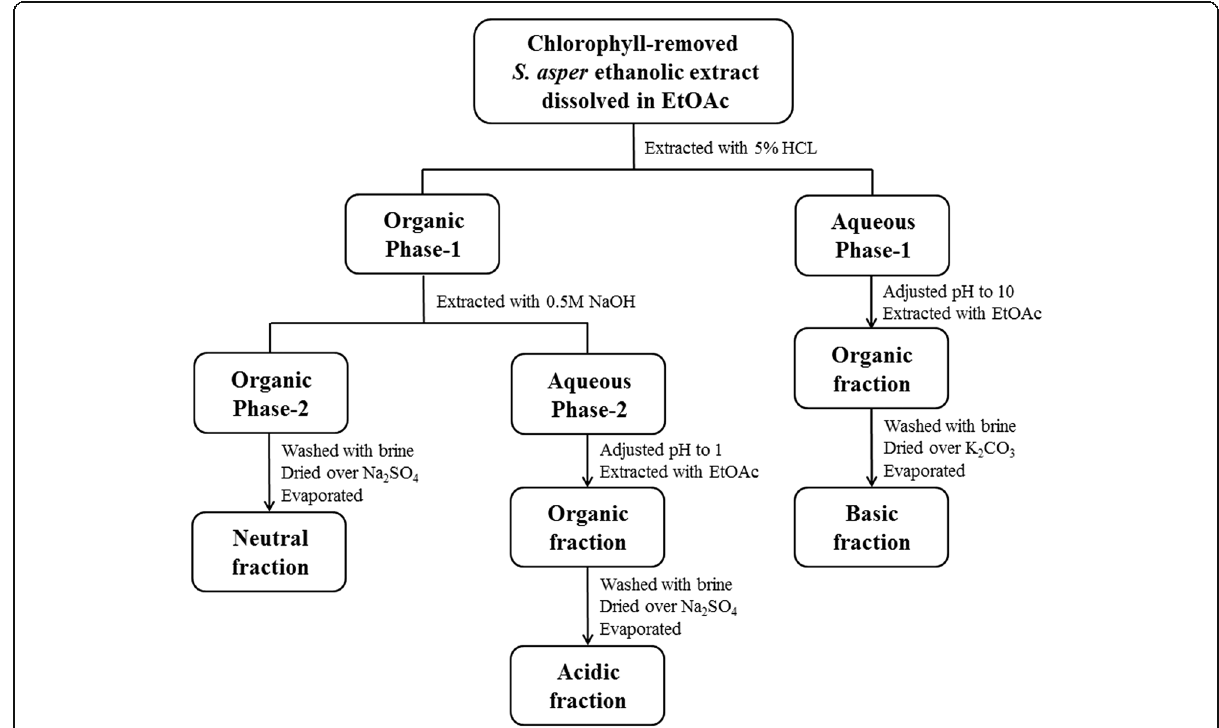
Fig. 1 Acid-Base extraction of S. asper ethanolic